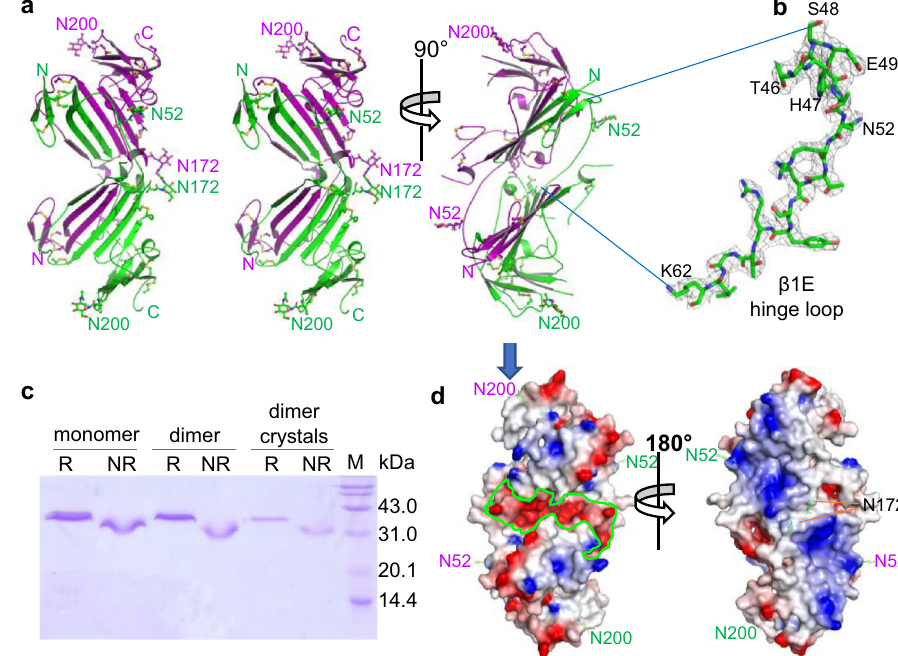
Fig. 2 D1 swapping promotes uPAR dimerization. a Stereo ribbon representations (left two panels) and a perpendicular view (right panel) of dimeric uPAR, with each protomer colored as green and magenta, respectively. Four N-terminal β -strands (residues 1 – 48) of one suPAR merges into the other molecule as the swapped domain. Sugar moieties and disul fi de bonds are shown as ball-and-sticks. b The domain 1 strand E ( β 1E) now becomes a hinge loop and links the swapped β -strands to the major domain (residues 63 – 277) of suPAR. The conformation of this hinge loop was veri fi ed by the 2Fo-Fc map electron density contoured at 1 sigma. c The SDS-PAGE of the crystals under reduced (R) or non-reduced (NR) conditions con fi rmed the presence of the intact full-length and non-covalently dimerized suPAR in the crystals. Source data are provided as a Source Data fi le. d Electrostatic surface representations of dimeric suPAR at two opposite faces (sugar moieties are shown in sticks and are labeled), viewed approximately along the 2-fold axis, showed a distinctly different charge distribution. The left panel was in the same orientation as in the right panel of a and showed the predominantly negatively charged groove (in bright green (Fig. 2b) as the critical structural transition when compared uPAR dimer with the monomer. In this hinge loop, the residues 47 – 49, located next to β 1D, appear to be the key hinge residues for uPAR dimer domain swapping. Previous studies on other domain swapped proteins showed that shortening or substituting the hinge region may favor one hinge conformation over the other 38,39 . We mutated these hinge residues to proline, pheny- lalanine, or alanine to study their roles for uPAR dimerization. uPAR T51C/V70C mutant was also generated to disrupt the dimerization by restricting the movement of β 1F away from β 1E.